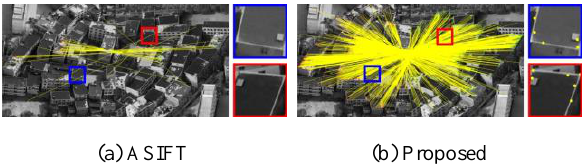
Figure 11. Matching results of ASIFT and the proposed method on image pair 5